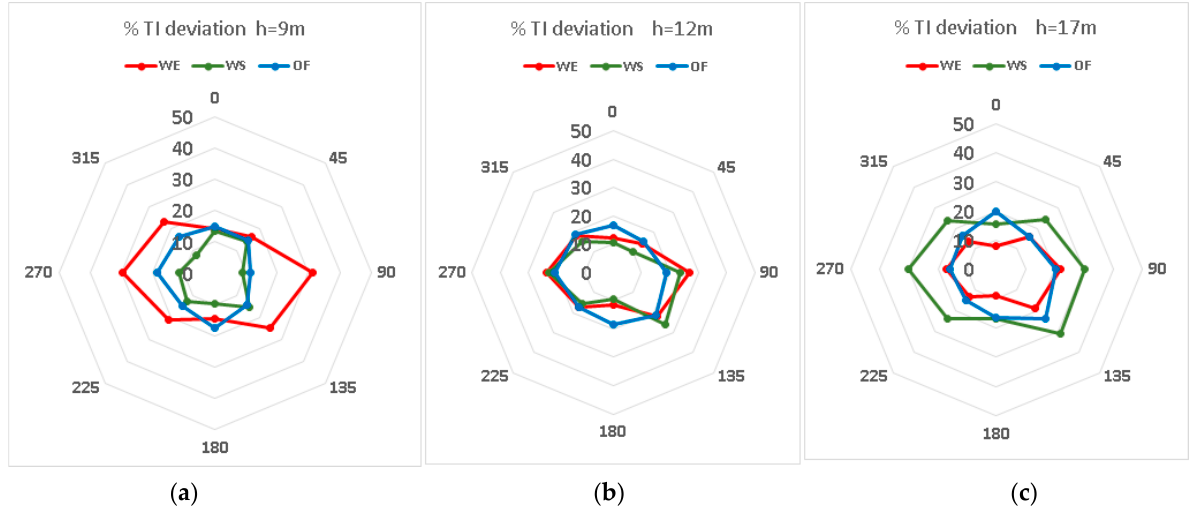
Figure 30. Overall mean turbulence intensity absolute deviation per points 1, 2, 3 and per height ( a )—9 m, ( b )—12 m, and ( c )—17 m above ground.